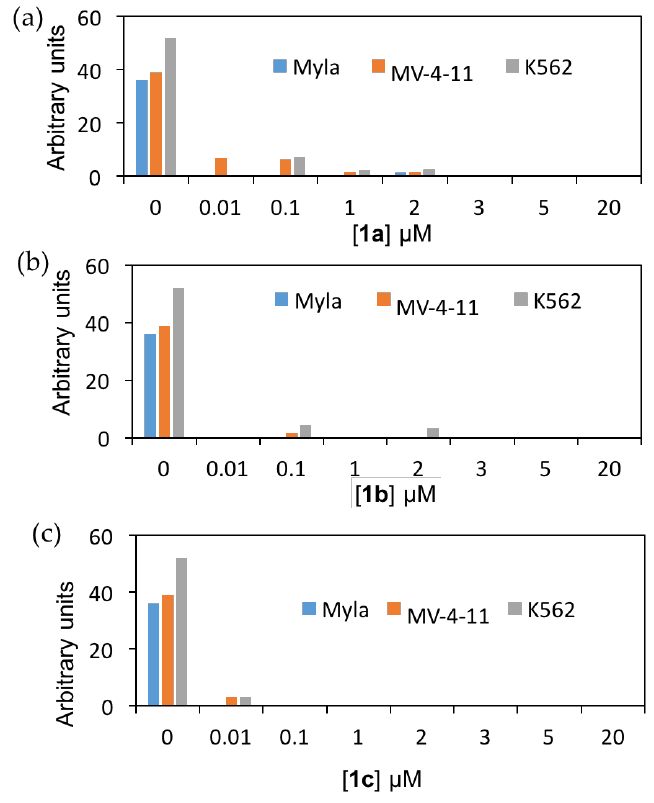
Figure 5. Telomerase activity (TA) in My-La, MV-4-11 and K562 cell lysates was investigated in the presence of 0–20 µM of ( a ) 1a , ( b ) 1b and ( c ) 1c ligands.